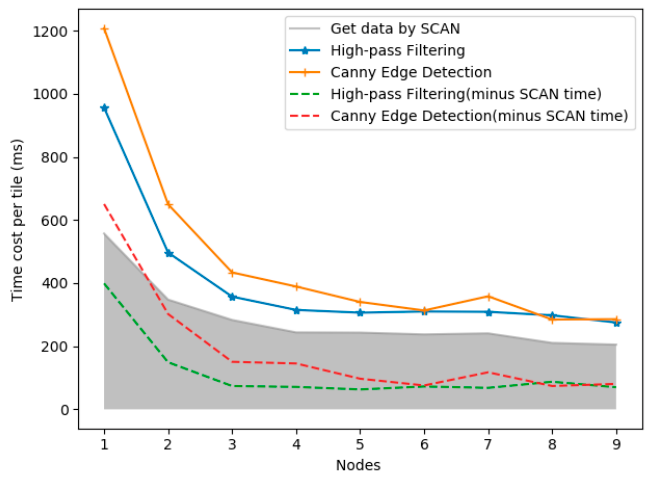
Figure 14. Time cost of two algorithms and SCAN.